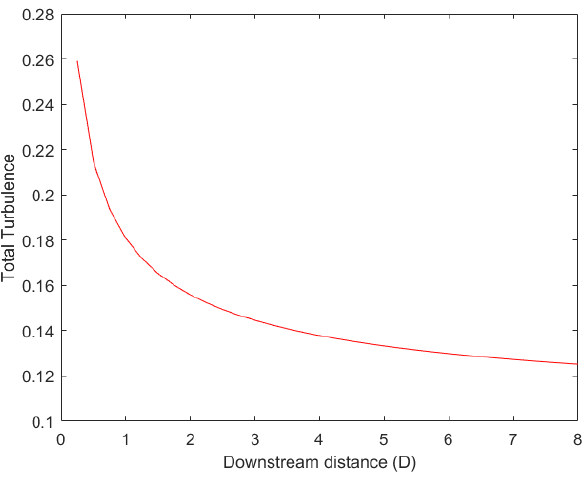
Figure 5. Effective turbulence for a selected wind turbine.